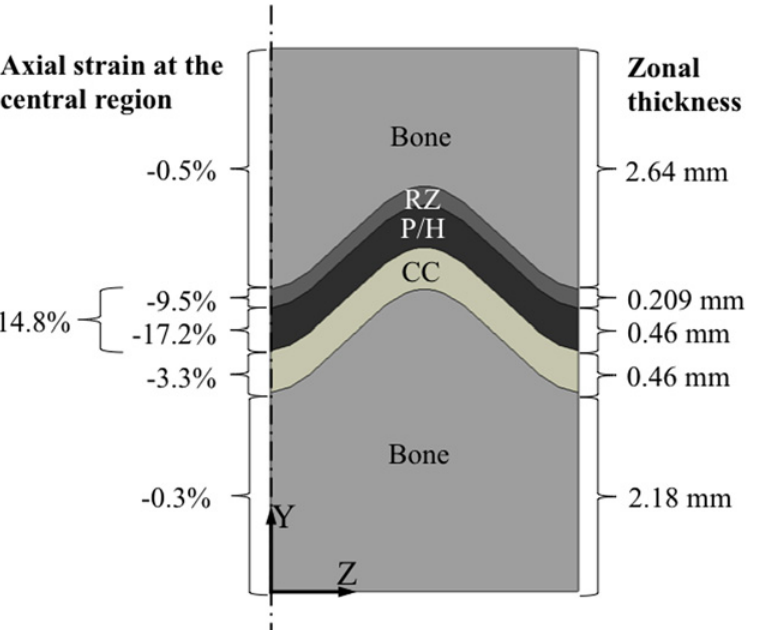
Fig 3. Different levels of axial strain were experienced by different zones (layers) of the sample. Although a compressive displacement equal to 20% of the growth plate thickness was applied to the top surface of the whole sample, the combined reserve zone and proliferative/hypertrophic (P/H) layers were subjected to engineering strains of only about 15%. Strains in the calcified cartilage (CC) zone reached about 3%